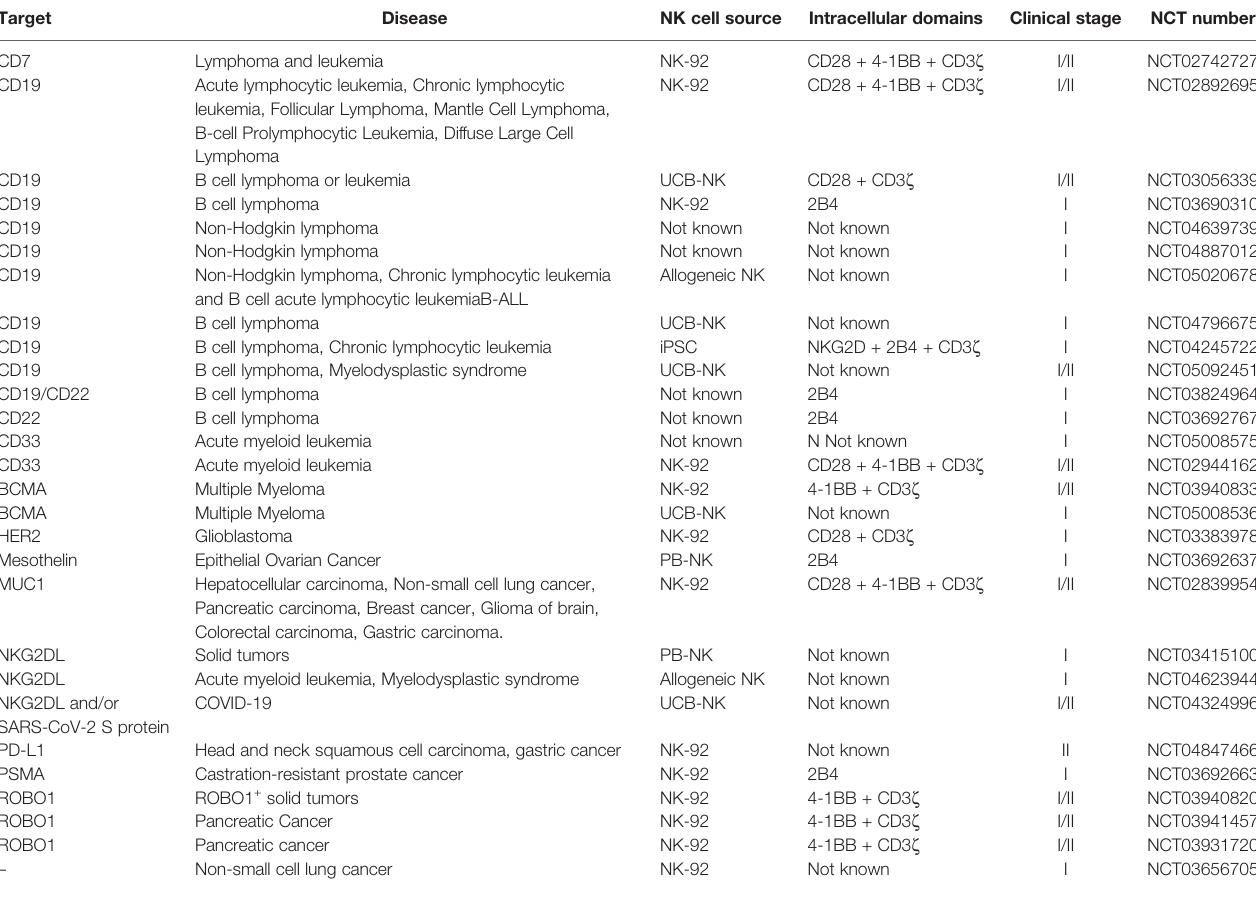
TABLE 2 | Ongoing clinical trials using genetically modi fi ed NK